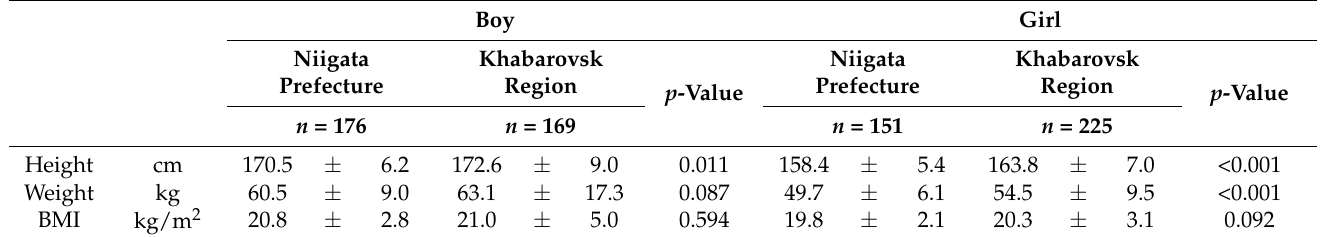
Table 1. Physical characteristics of Niigata and Khabarovsk’s adolescents, n = 721. Boy